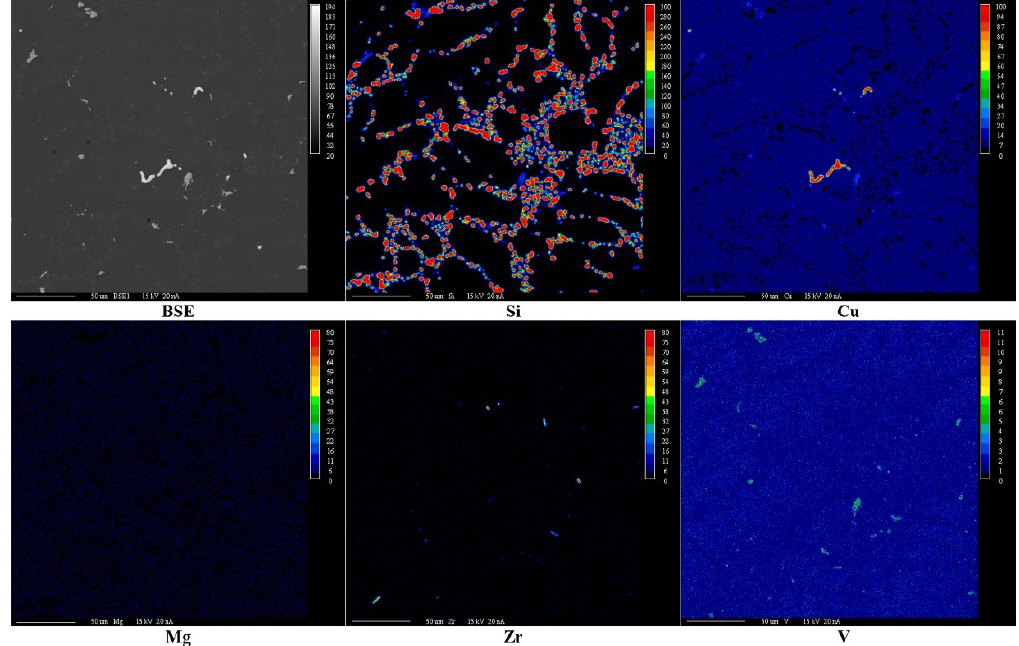
Figure 2. As-quenched microprobe cartography (1 pixel for 0.5 µm).